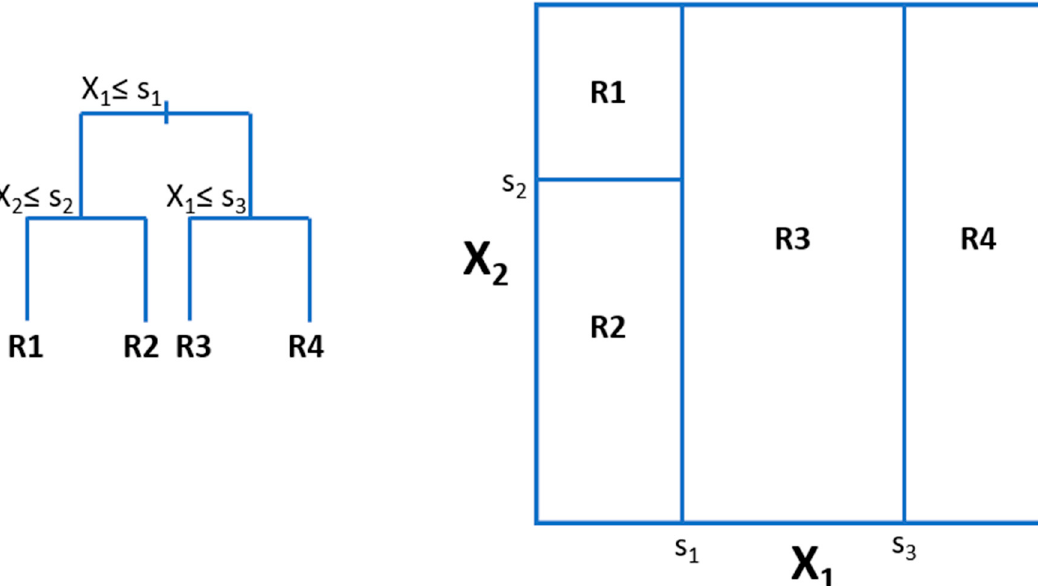
Figure 3. Depiction of Decision Tree for two variables, X 1 and X 2. R1 , R2, R3, and R4 are partitions generated by the splits s 1 , s 2 , and s 3 . The labels for the partitions would be a function of the labels of the instances in each partition in the training